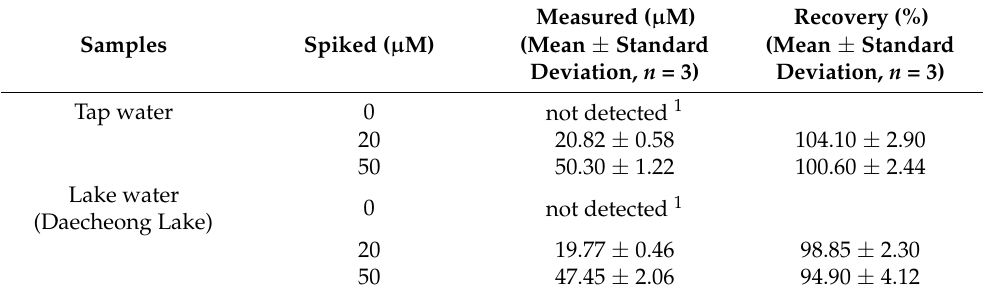
Table 1. Comparison of phosphate detection in real water samples using the proposed Eu-TCA/GMF.